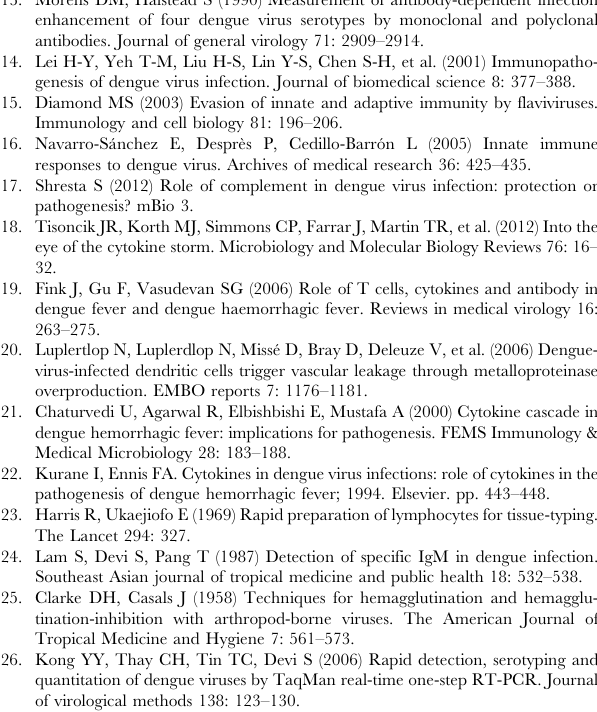
Figure S1 Innate immune response mega canonical pathway created using Ingenuity Pathway Analysis. Figure S5 for a legend explaining Pathway molecule symbols. For Figure S2 Adaptive immune response mega canonical pathway created using Ingenuity Pathway Analysis. Please refer to Figure S5 for a legend explaining Pathway molecule symbols. For additional information, visit IPA legend help page at Figure S3 Role of cytokines in mediating communica- tion between immune cell canonical pathways from Ingenuity Pathway Analysis. Please refer to Figure S5 for a legend explaining Pathway molecule symbols. For additional